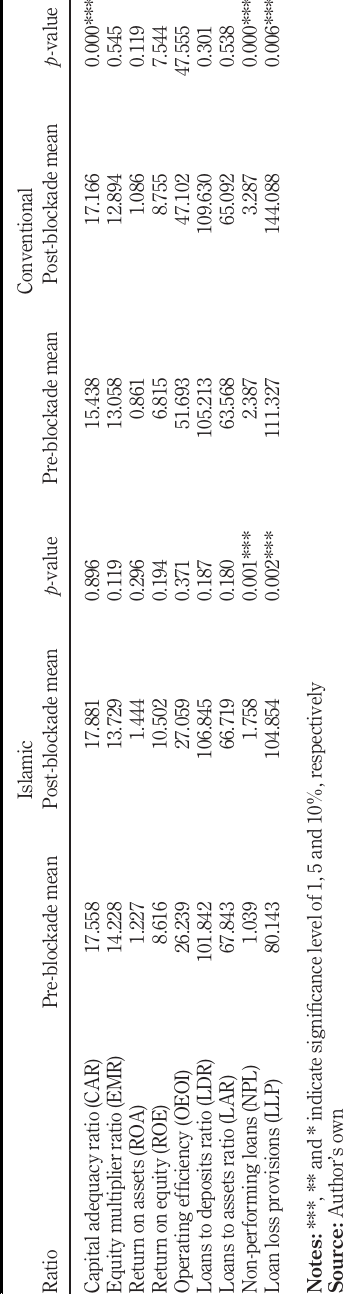
Table 7. Impact of the blockade on bank